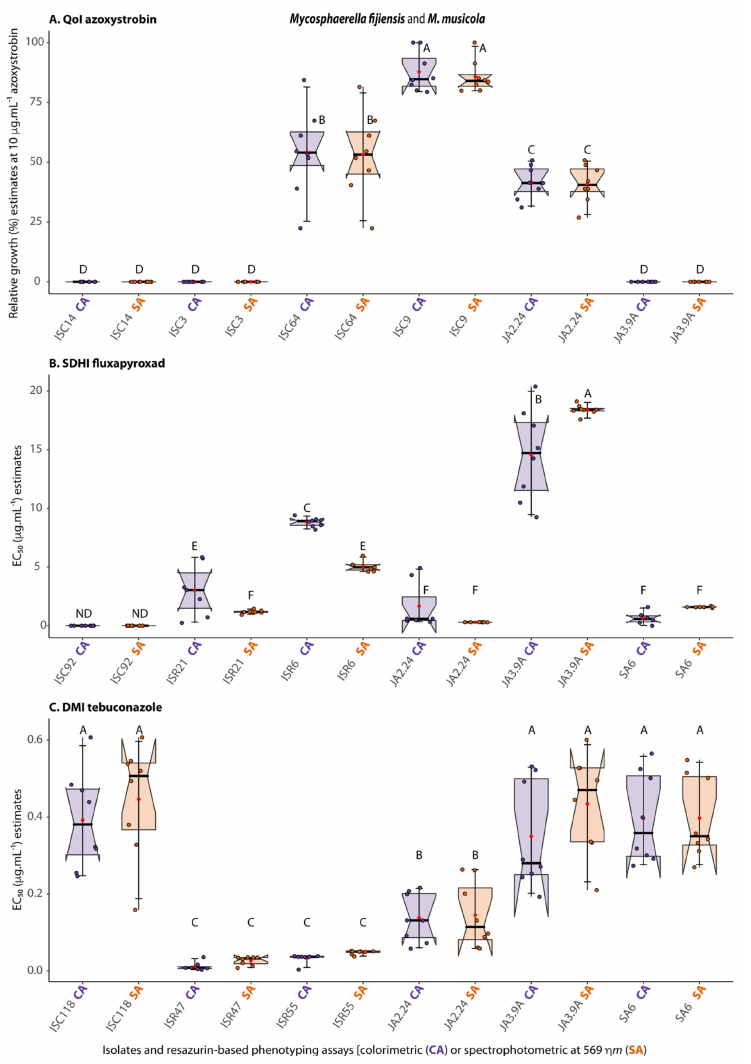
Figure 5. Correspondence between fungicide resistance categories (based on EC 50 values or relative growth estimates) as a measure of accuracy of the resazurin-based colorimetric assay (CA = COL-assay, purple boxplots) in comparison with the classical spectrophotometry detection assay (SA = SPEC-assay, orange boxplots) for testing sensitivity of Mycosphaerella fijiensis or M. mu- sicola to QoI ( A ), SDHI ( B ), or DMI ( C ) fungicides a,b . a The COL-assay was based on analyses of digital images of experimental microplates captured with mobile phone cameras on a handmade trans-illuminator designed for colorimetric estimation of RZ reduction from T0 to T24 using the ReadPlate3.0 in ImageJ developed by Delfino [21] as described in item 2.6 from this study. b The figure depicts boxplots with the medians represented by black lines across the notches, the average as red circles along the whisker lines, and the jittered data points in purple or orange to avoid data overplotting. The F statistics for treatment effect was significant at least at p ≤ 0.05. Boxplots with the same letter on top (from A to F) indicate that the means for the particular isolate or resazurin-based phenotyping assay are not significantly different by the Scott–Knott test at α ≤